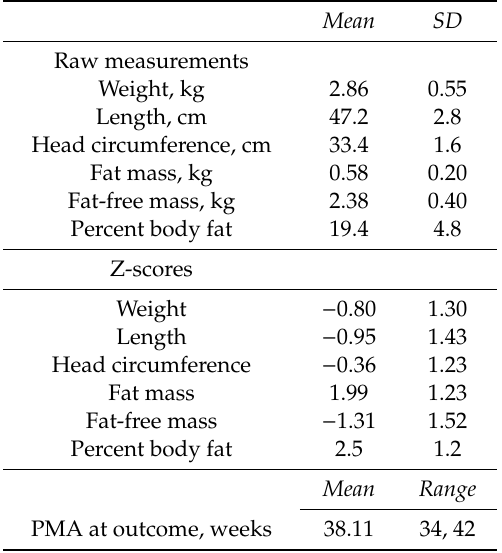
Table 2. Anthropometry and body composition outcomes at term equivalent age ( n = 37). Mean SD Raw measurements Weight, kg 2.86 0.55 Length, cm 47.2 2.8 Head circumference, cm 33.4 Fat mass, kg